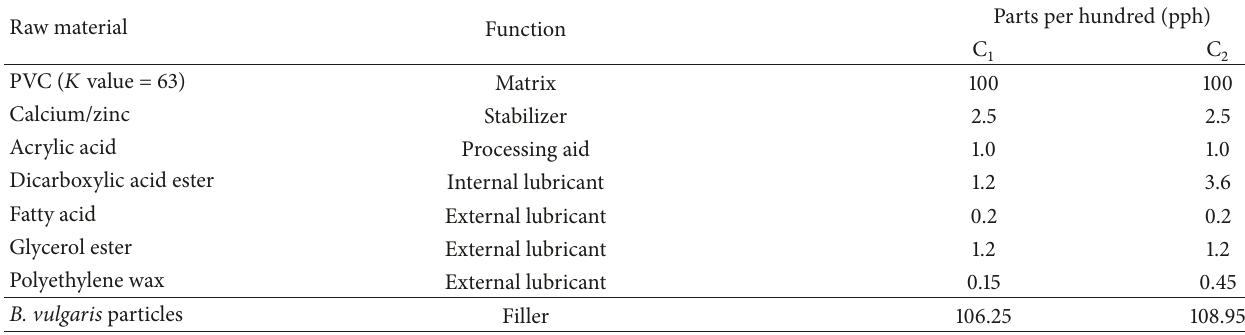
Table 1: Composition of PVC, additives, and 50% B. vulgaris particles for the dry-blend process.